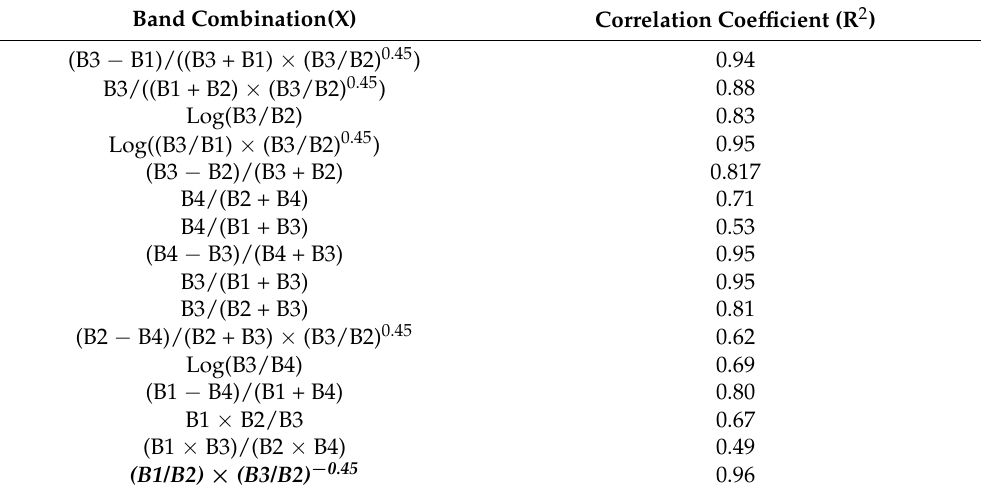
Table 2. Band combination and R 2 .